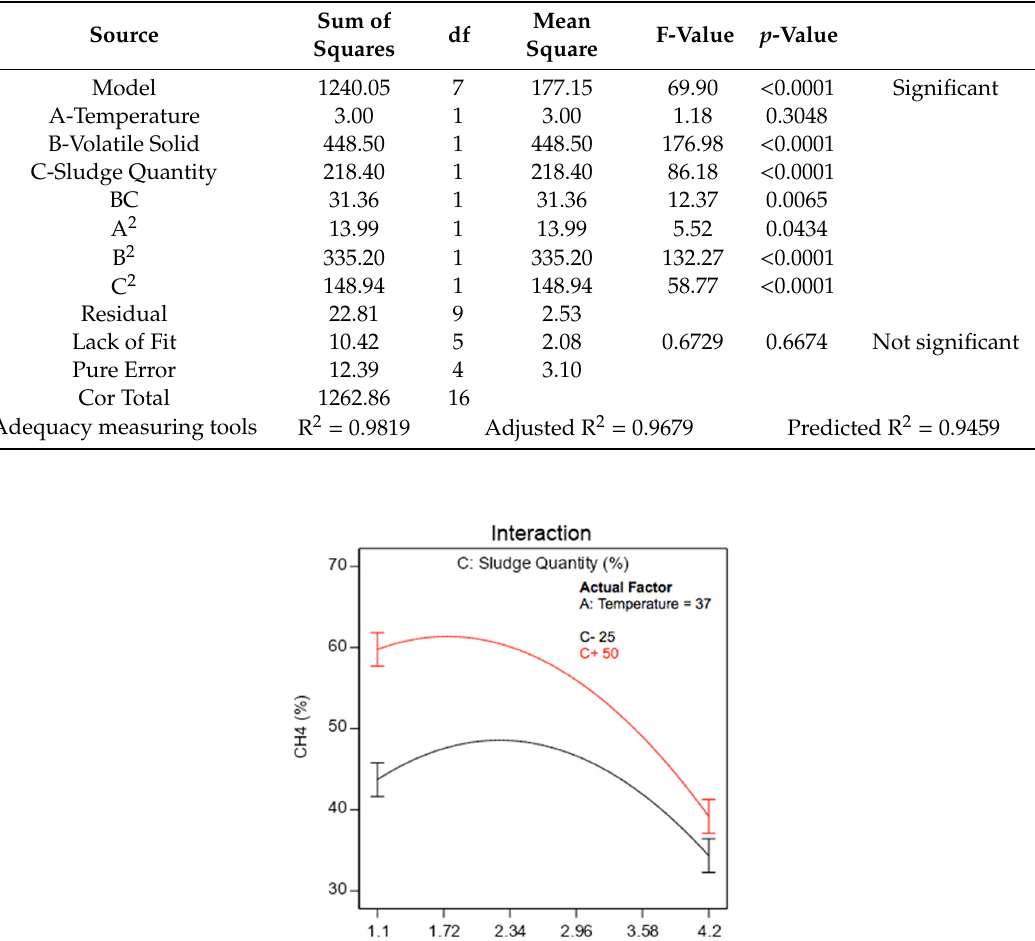
Table 7. ANOVA table for CH 4 % response.